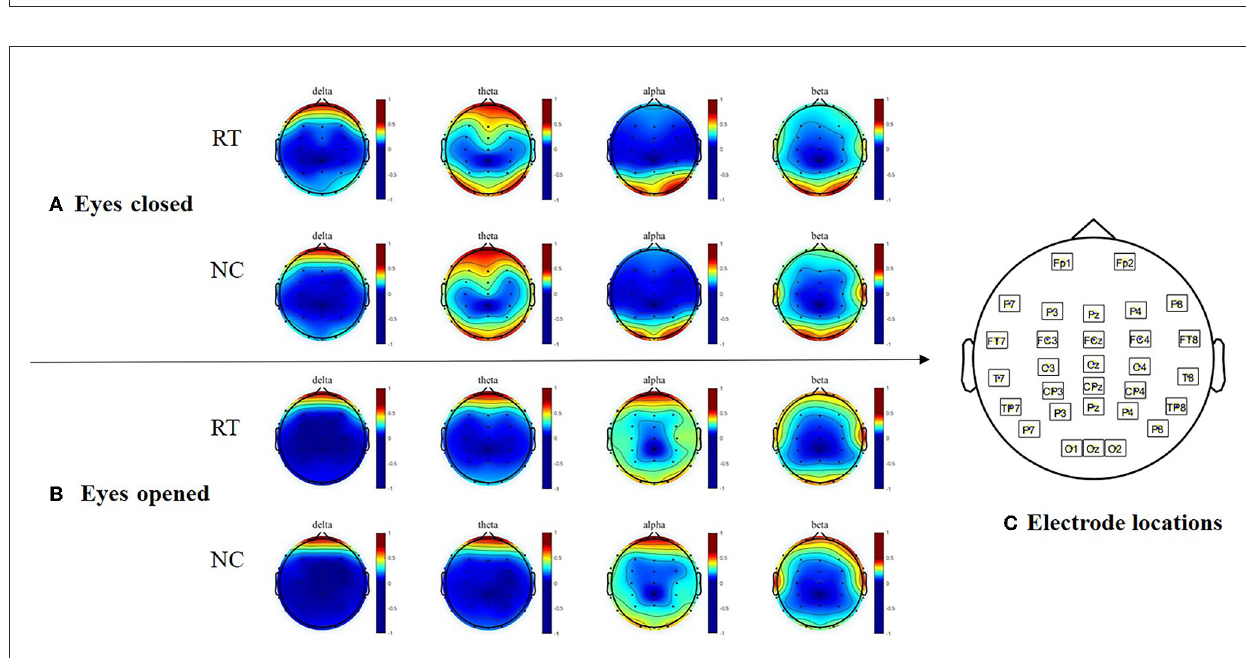
FIGURE2 Topographical maps of absolute power in resting state EEGs. (A) Topographical maps of absolute power with eyes closed. (B) Topographical maps of absolute power with eyes opened. (C) Electrode locations of the EEG cap. RT, Rumination group; NC, control group.